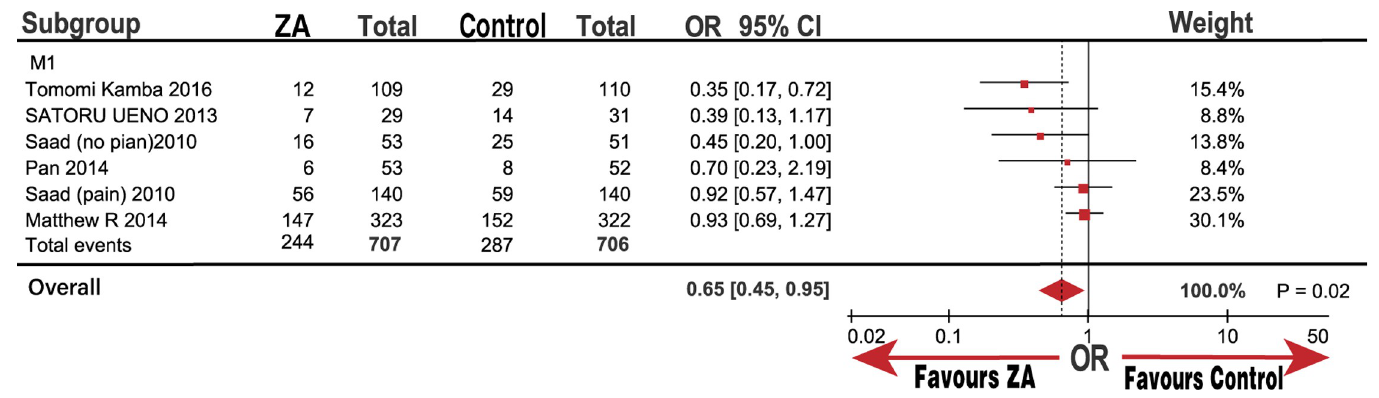
Fig 7. Forest plot odds ratio (OR) of Skeletal related events (SREs) in subgroup of M1.